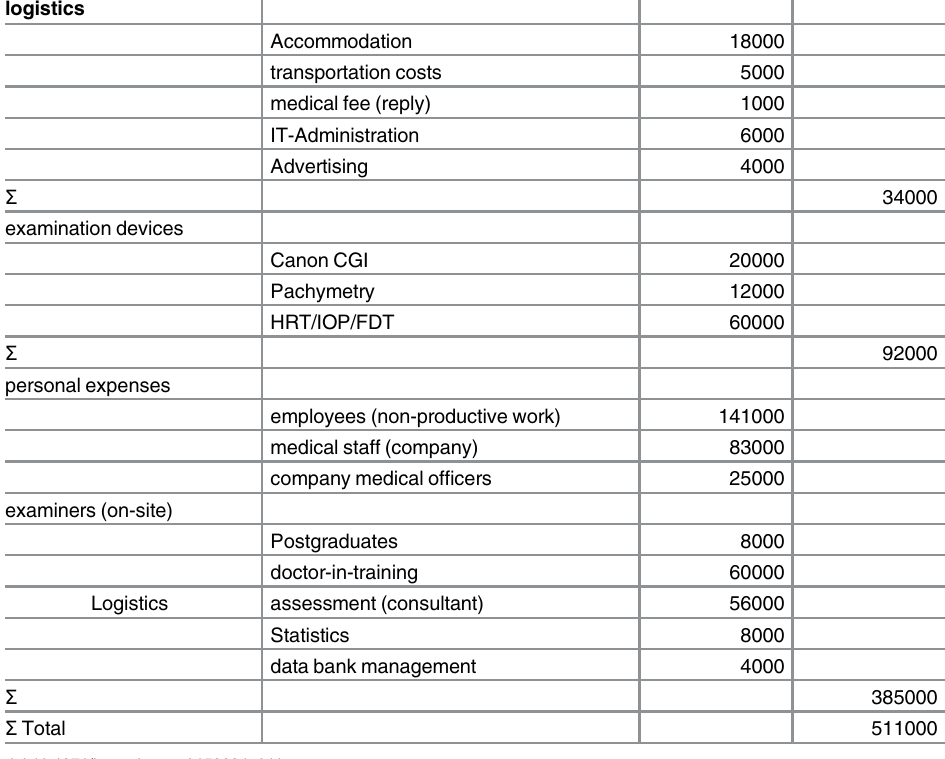
Table 11. Cost-calculation of the whole